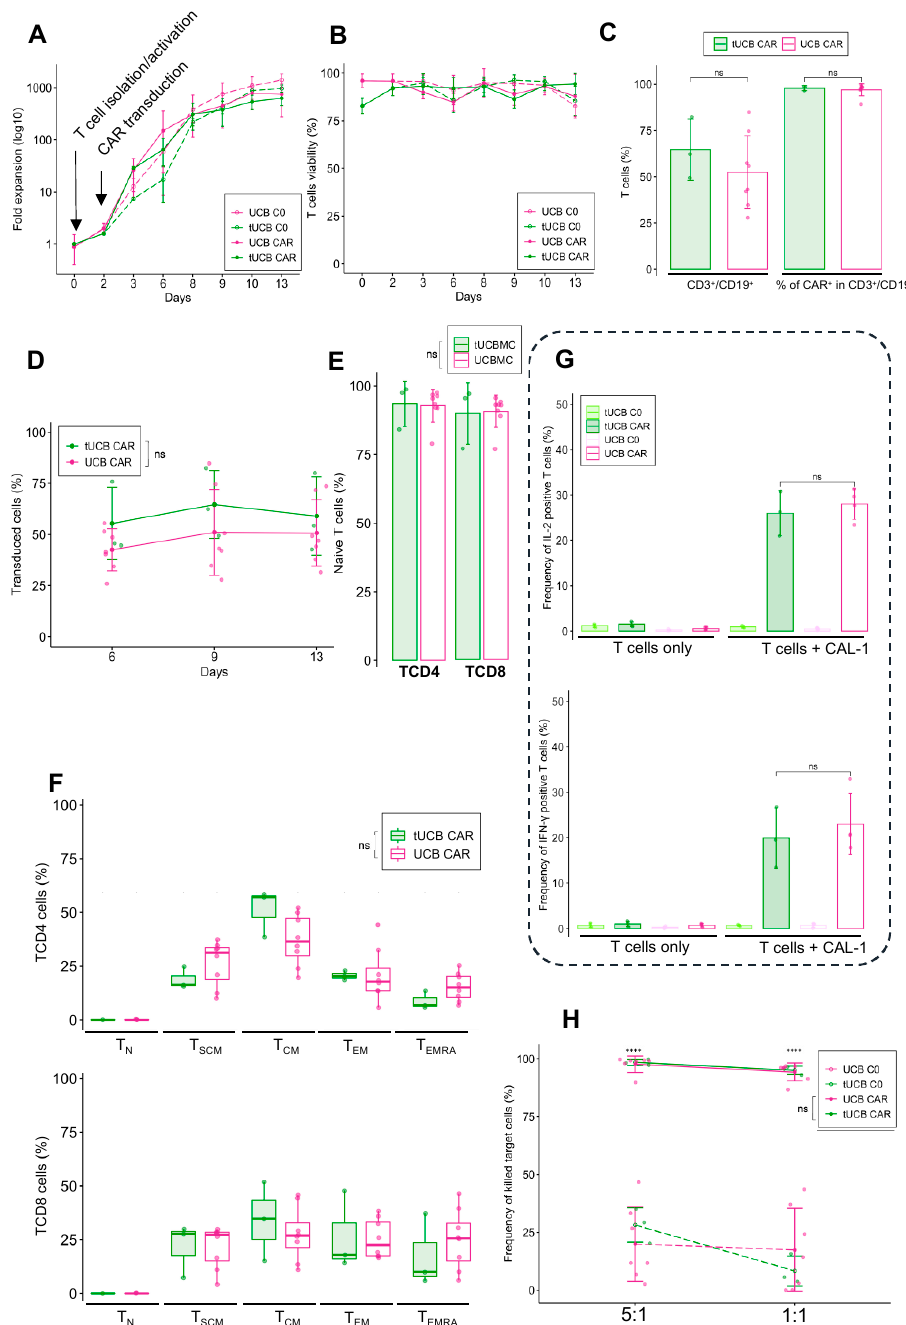
Figure 5. Generation of functional UCB CAR-T from cryopreserved/thawed UCB. ( A ) Fold expansion of untransduced T cells from thawed (tUCB C0) and fresh UCB (UCB C0), and CAR-T cells from thawed (tUCB CAR-T) and fresh UCB (UCB CAR-T) after T cell isolation, activation, and transduction ( n = 3 for tUCB, n = 8 for UCB). ( B ) T cell viability over time, as determined using the trypan blue exclusion test, for tUCB C0, UCB C0, tUCB CAR-T, and UCB CAR-T after T cell isolation, activation, and transduction ( n = 3 for tUCB, n = 8 for UCB). ( C ) Percentage of transduced cells determined by transduction rate, and CAR expression for thawed UCB CAR-T and fresh UCB ( n = 3 for tUCB and n = 8 for UCB). ( D ) Transduction rate over time for tUCB CAR-T and UCB CAR-T ( n = 3 for tUCB and n = 8 for UCB). ( E ) Percentage of naïve T cells derived from UCB, for the TCD4 and TCD8 phenotypes before activation ( n = 3 for tUCBMC and n = 10 for UCBMC). ( F ) Differentiation profile for